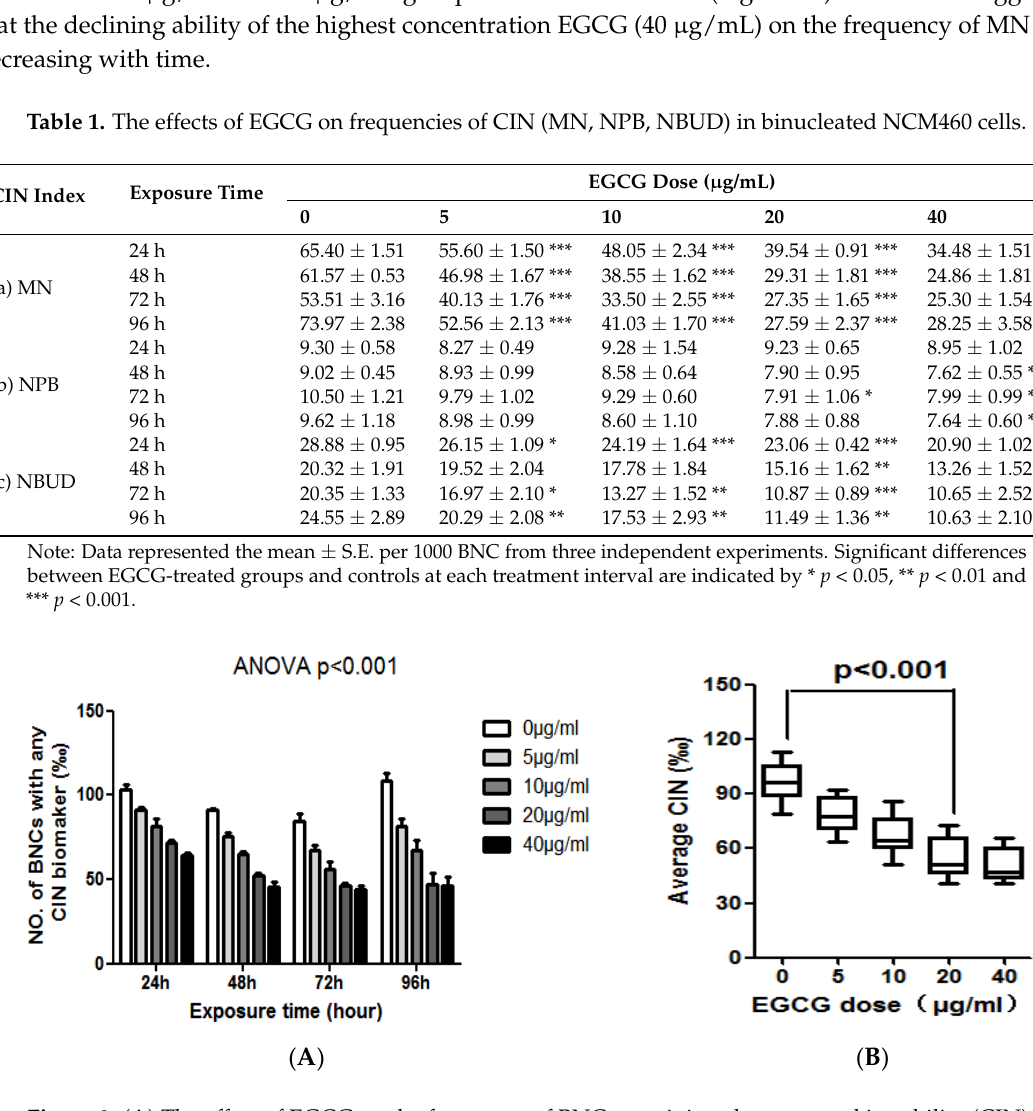
Figure 2. ( A )The effect of EGCG on the frequency of BNC containing chromosomal instability (CIN) Figure 2. ( A ) The effect of EGCG on the frequency of BNC containing chromosomal instability biomarkers (MN and/or NPB and/or NBUD); ( B ) The average effect of 96-h exposure to EGCG at doses of 0, 5, 10, 20, 40 μg/mL on CIN frequency in the NCM460 cell line.